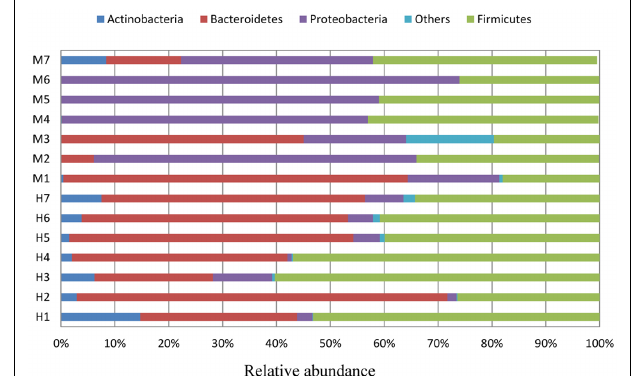
FIGURE 3 | Each individual of two groups of children (healthy, H1 ∼ H7; malnourished, M1 ∼ M7) showing relative abundance (percentage of sequences) of the dominant gut bacteria.